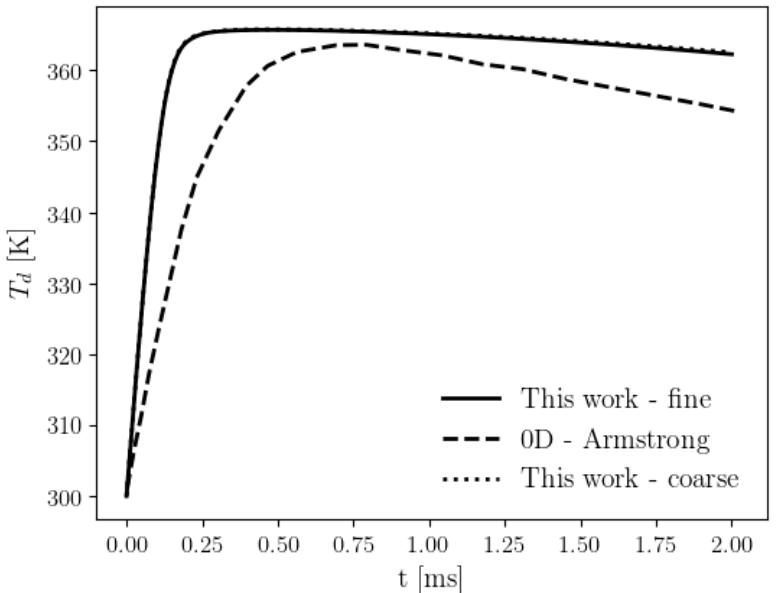
Figure 6. Temporal evolution of the droplet temperature. Solid line, results from this work for a fine grid (8750 cells); dotted lines, results for a coarse grid (5600 cells); and dashed line, results from Armstrong’s model [22]; water droplet of R 0 = 10 µ m at 300 K, λ = 10.6 µ m, I 0 = 10 7 W/m 2